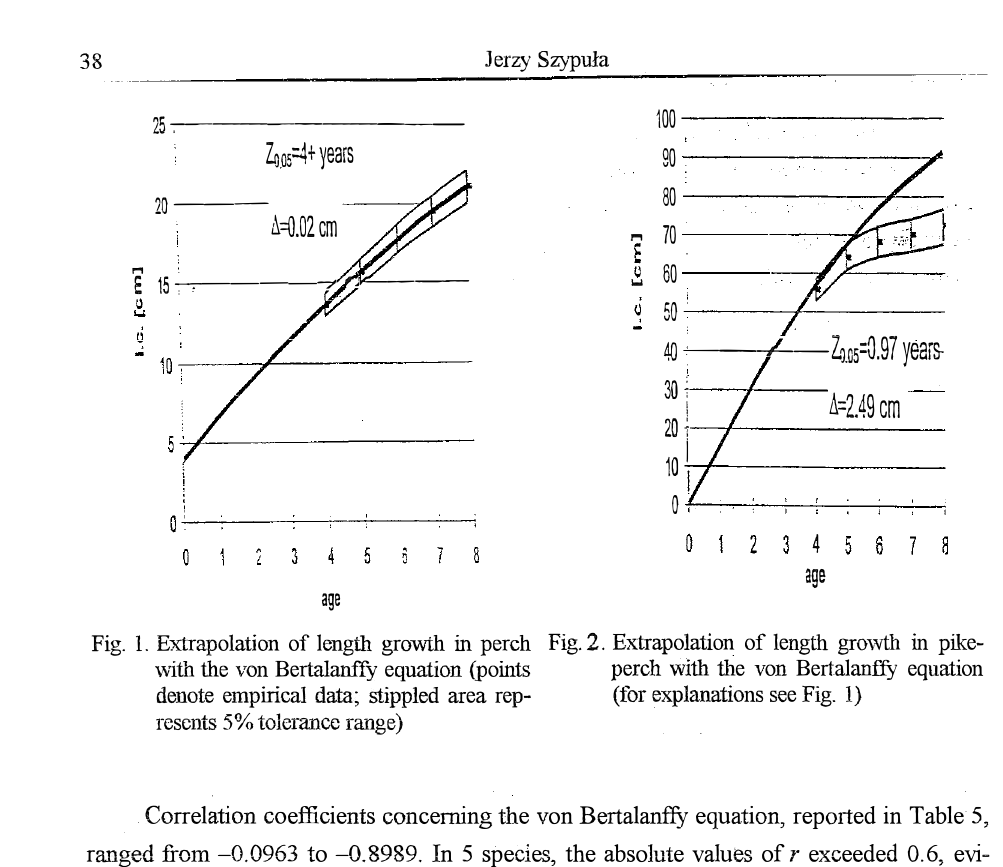
Fig. 2. Extrapolation of length growth in pike­ Fig. I. Extrapolation of length growth in perch perch with the von Bertalanffy equation with the von Bertalanffy equation (points (for explanations see denote empirical data; stippled area rep­ resents 5% tolerance range)